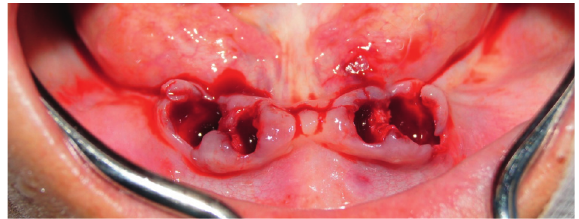
Figure 2: Fresh postextraction sockets.